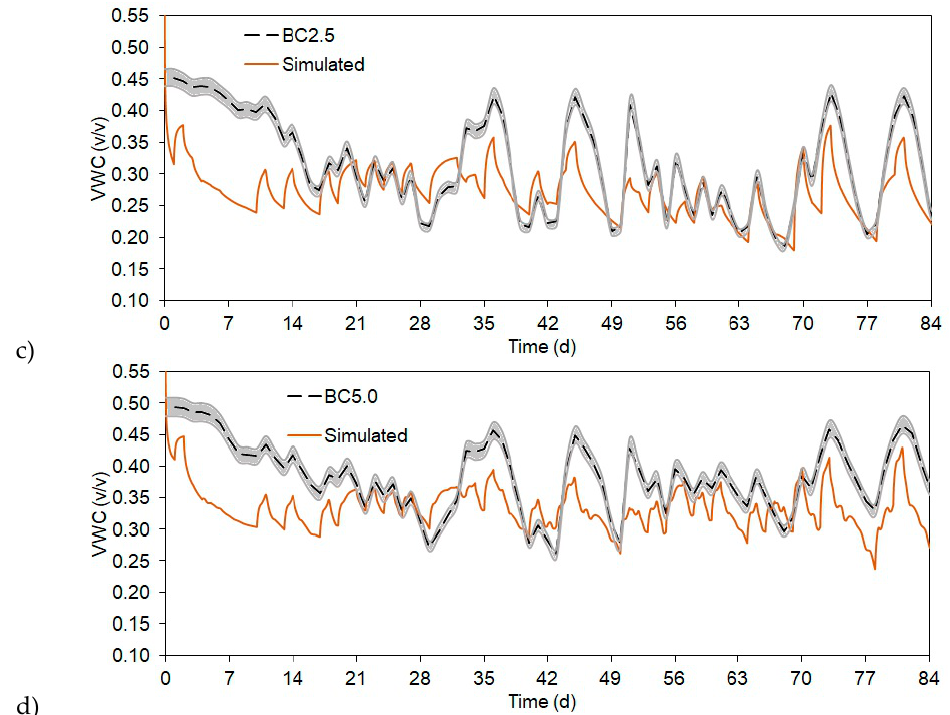
Figure 4. Observed and simulated soil water content (SWC) as volumetric water content (VWC) changes for the different treatments. a ) control, b ) BC0.5, c ) BC2.5, and d ) BC5.0. Grey area represents measured SWC uncertainty of 1.5%.